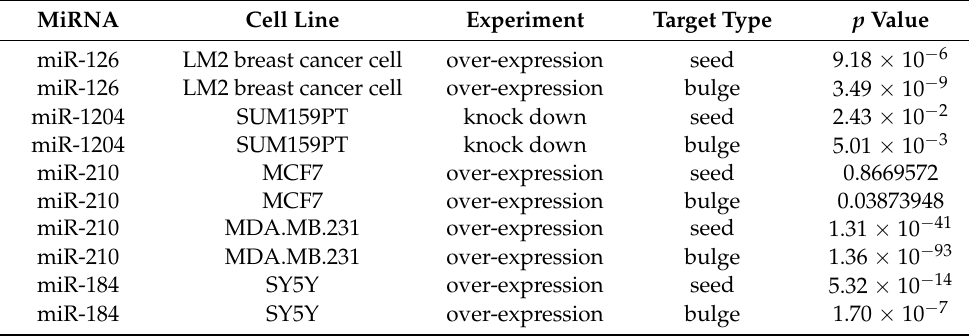
Table 2. Functional analyses of CG dimer miRNAs in the transfection data. MiRNA Cell Line Experiment Target Type p Value miR-126 LM2 breast cancer cell over-expression seed miR-126 LM2 breast cancer cell over-expression bulge miR-1204 SUM159PT knock down seed miR-1204 SUM159PT knock down bulge over-expression seed miR-210 MCF7 over-expression bulge 0.03873948 miR-210 MDA.MB.231 over-expression MDA.MB.231 over-expression bulge over-expression